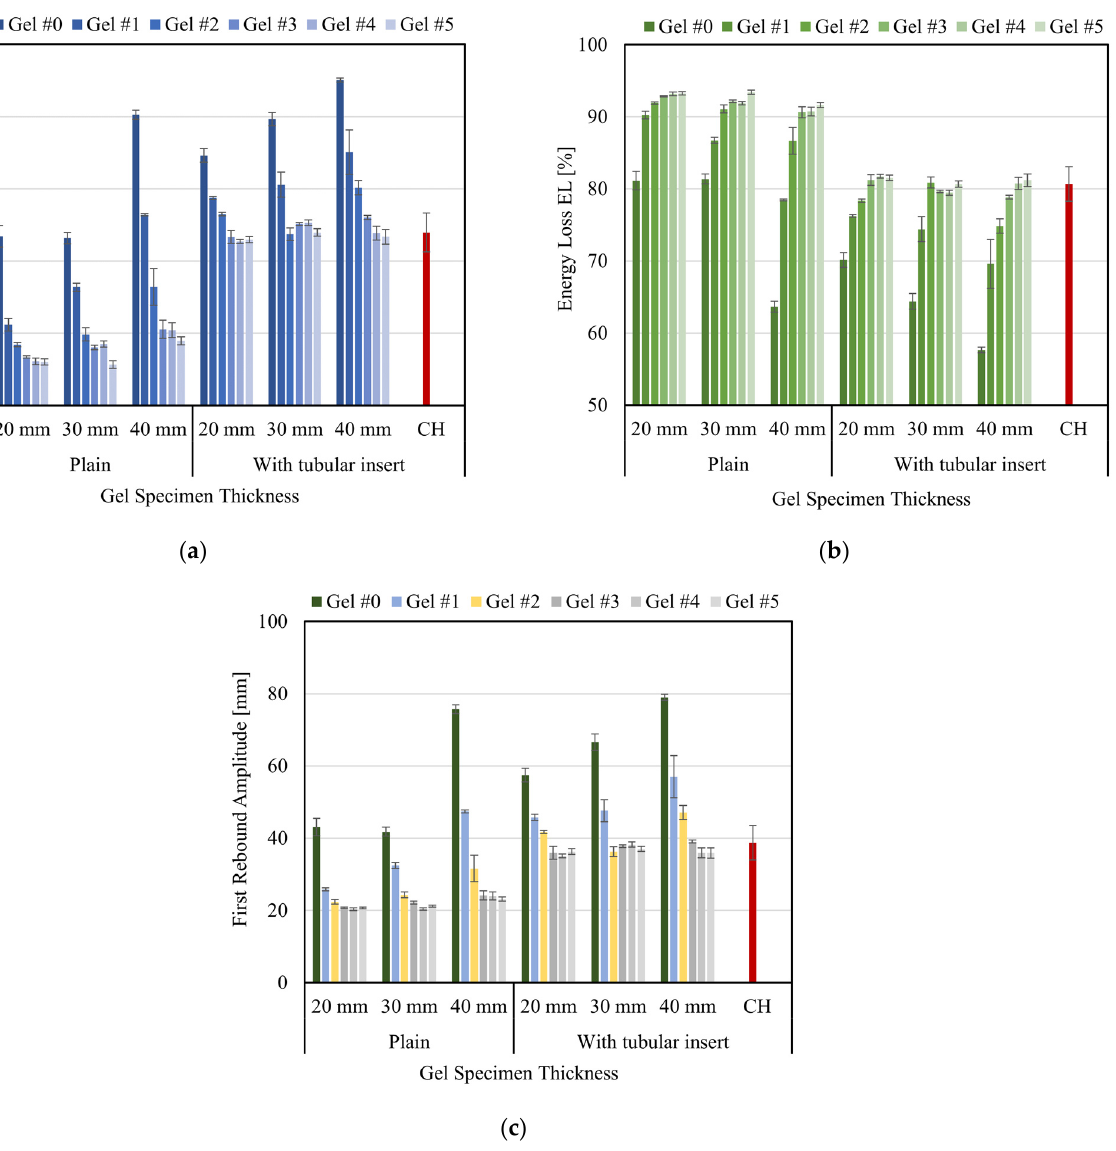
Figure 8. ( a ) Impact sequence for gel #3, 40 mm thick; ( a ) Plain specimen; ( b ) Specimen with tubular insert. Time in min:sec.milliseconds.